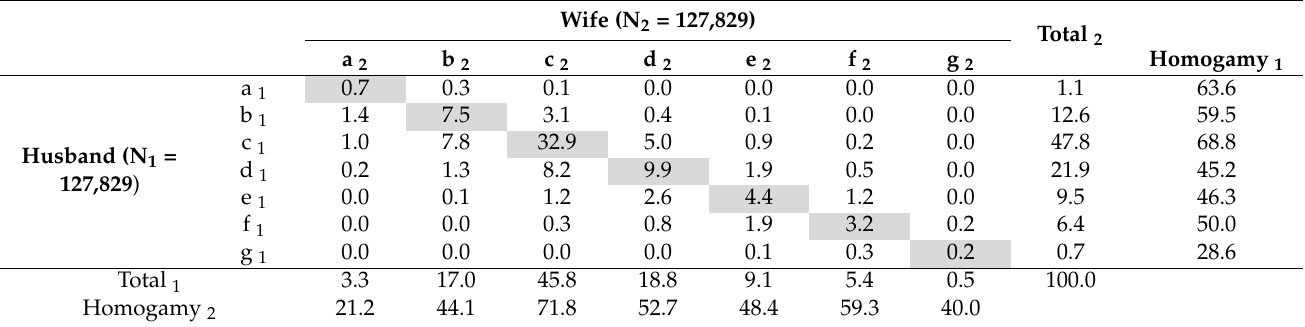
Table 2. Comparison of educational level between husband and wife (%).